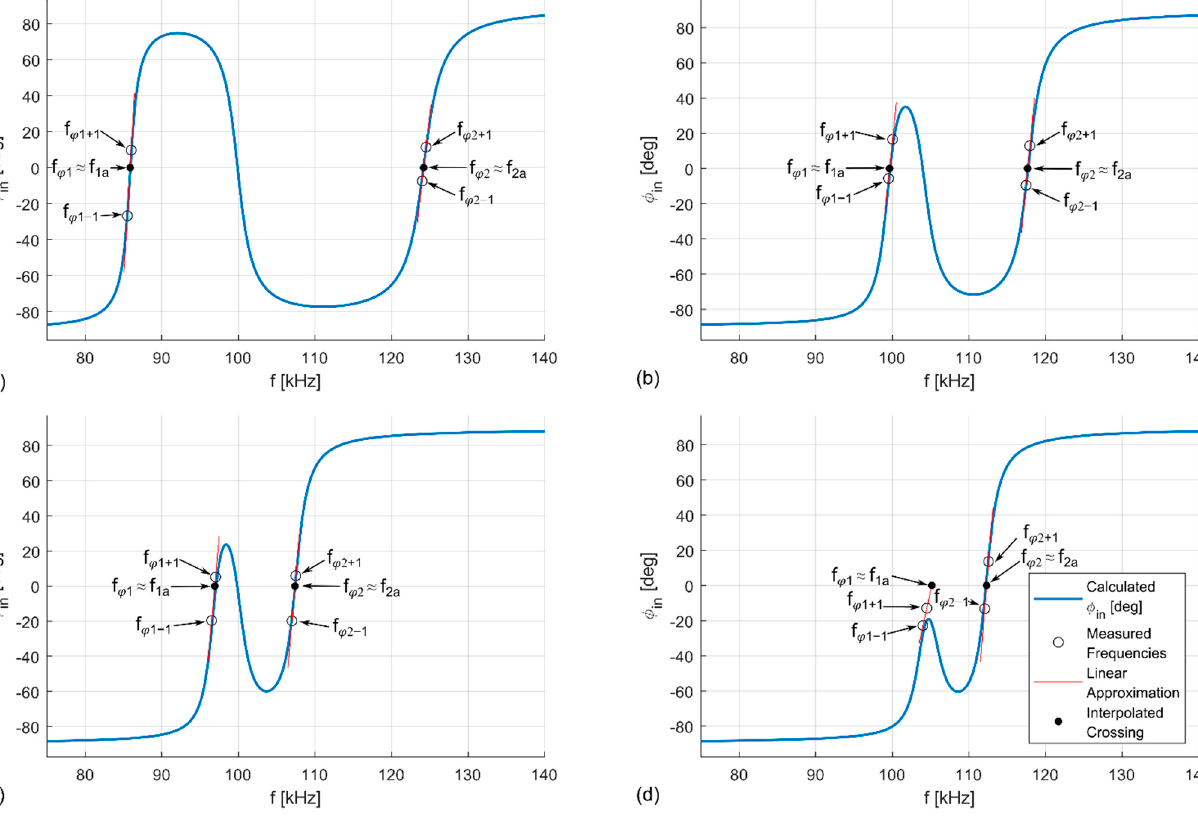
Figure 11. Influence of detuning on the bifurcation asymptote method. ( a ) Tuned system (x = 0 mm). ( b ) Detuned system with medium coupling coefficient 𝑘 (x = 130 mm). ( c ) Detuned system with small 𝑘 (x = 60 mm). ( d ) Detuned system with very small 𝑘 (x = 180 mm). The discrepancies between the measured data points and calculated frequency response (especially in ( d )) are caused by high sensitivity of frequency responses for low 𝑘 and the influence of the ferrites.